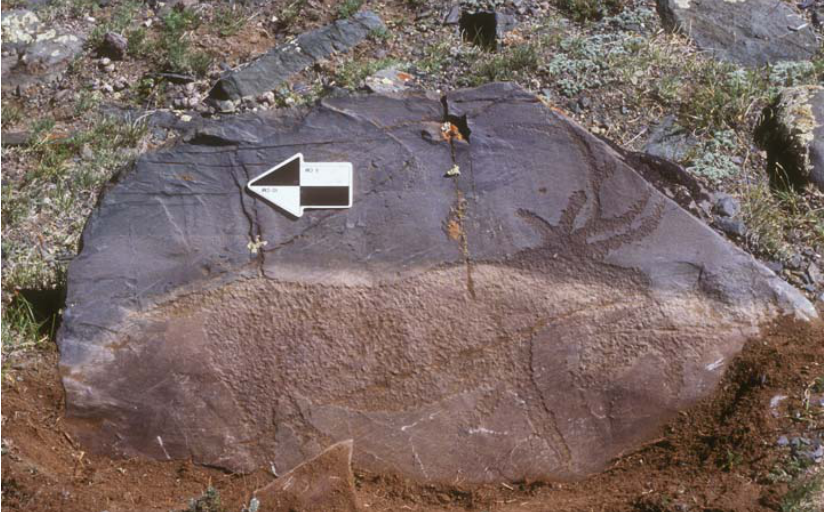
Figure 11. Elk image on uncovered boulder. Early Bronze Age. Tsagaan Salaa III.